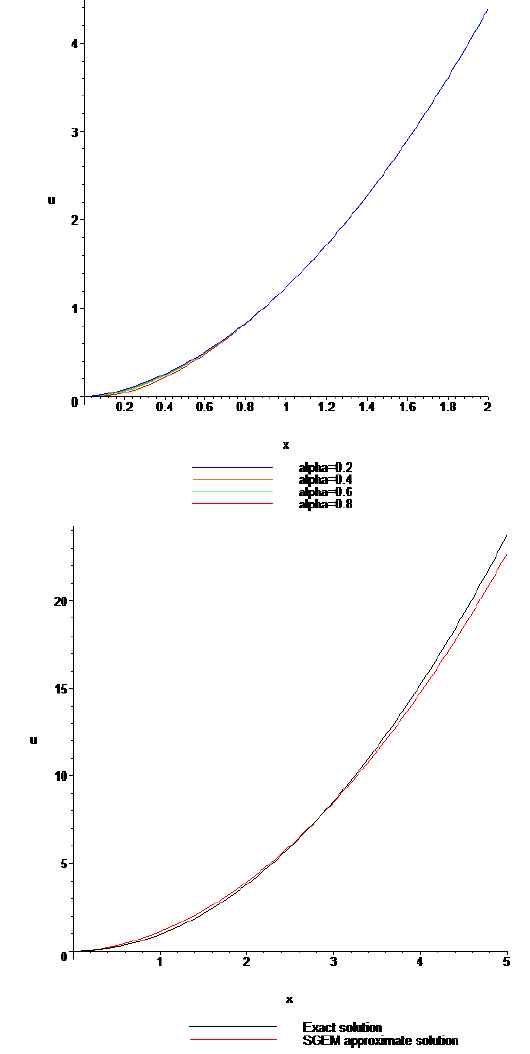
Figure 3. The solutions obtained via Bernoulli approximation